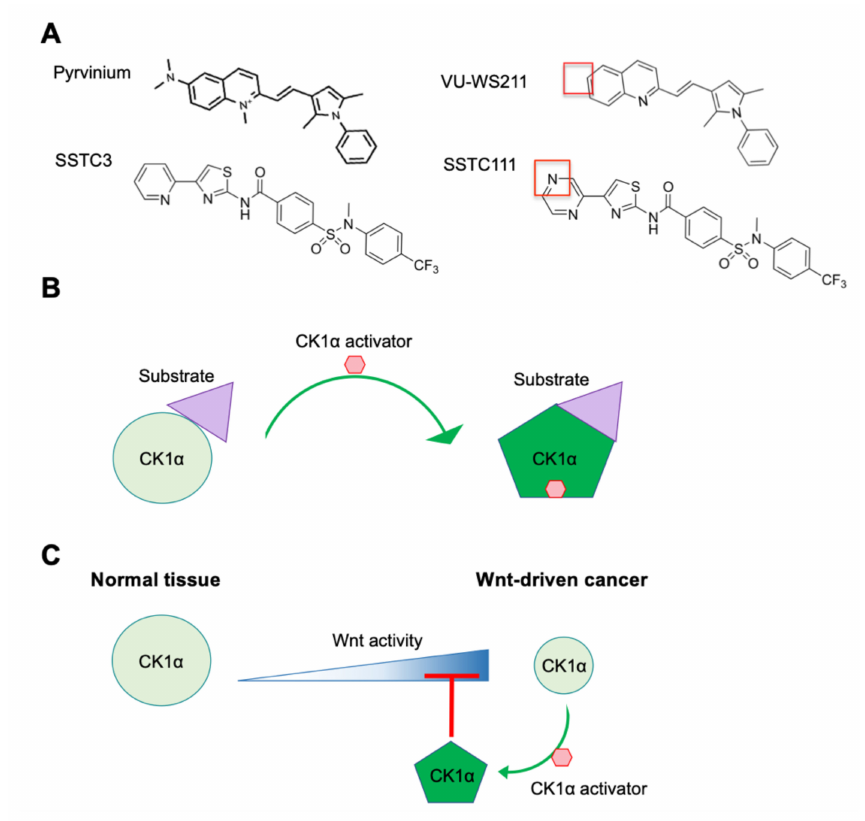
Figure 4. CK1 α activators. ( A ) The structures of two chemically distinct CK1 α activators—pyrvinium and SSTC3—and their inactive analogs—VU-WS211 and SSTC111—respectively, are shown. The red boxes highlight key structures needed for maximal e ffi cacy. ( B ) A model, highlighting how CK1 α activators function to increase the catalytic e ffi ciency of CK1 α . ( C ) A model of the mechanism underlying the di ff erential therapeutic index of CK1 α activators in normal tissue and Wnt-driven